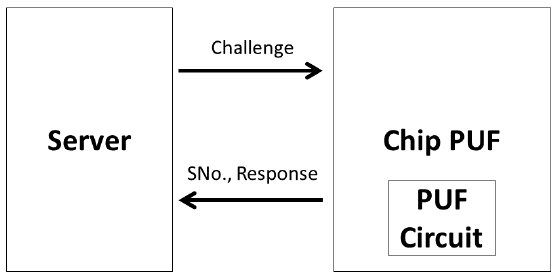
Figure 12. PUF based enrollment. Adapted from